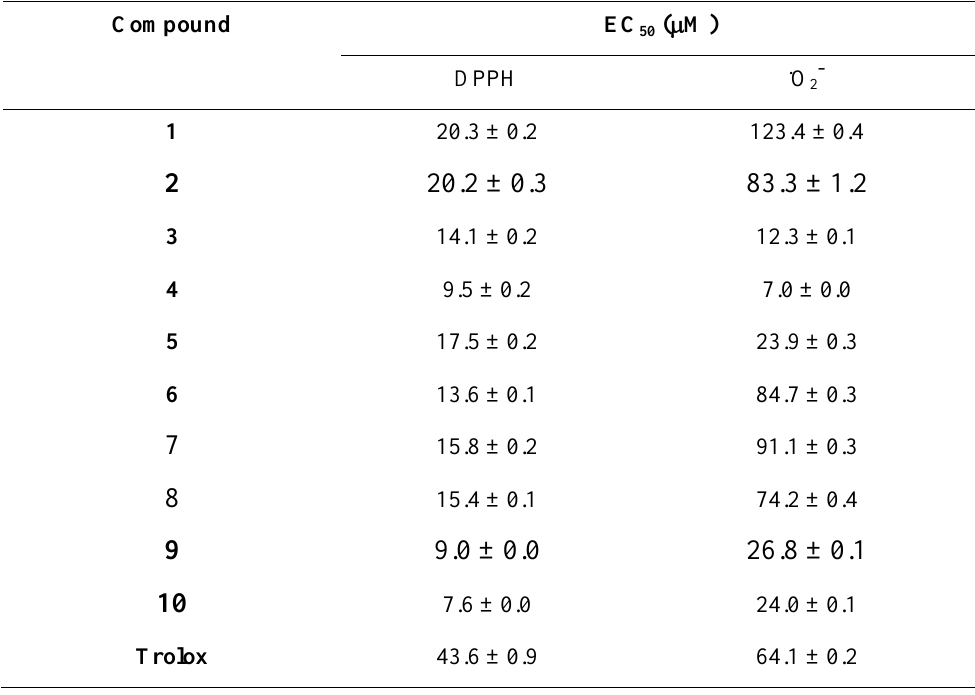
Table 2. Radical scavenging activities of